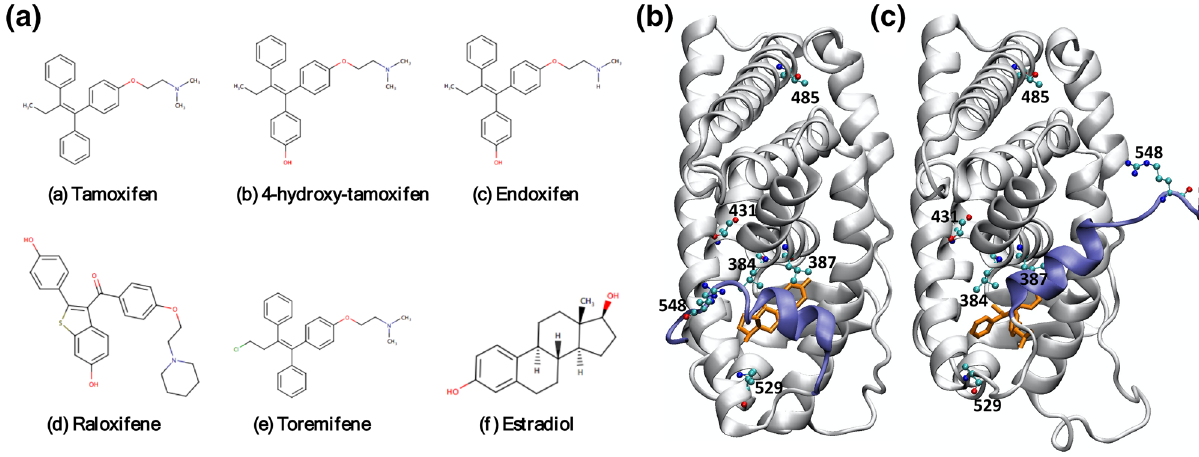
Figure 1. Chemical structures of the 6 ligands that have been investigated ( a ), and positions of the mutations identified from 50 breast cancer patients of Qatari nationals, in both the active ( b ) and inactive ( c ) conformations. The PDB code of the active conformation crystal structure is 1QKU, and the inactive conformation is 3ERT. The ligands presented in the crystal structures are represented as stick in orange, the protein is shown as cartoon in silver. The helix 12 (H12) is highlighted in blue, which shows different orientations in the active ( b ) and inactive ( c )